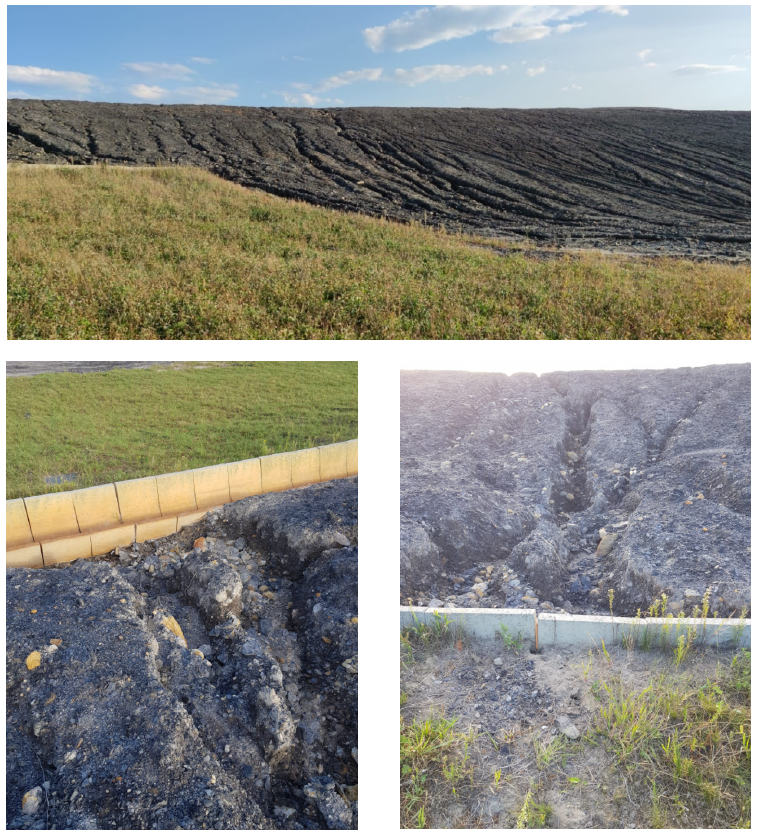
Figure 14. The applied reinforcement has prevented rainfall-induced soil erosion.